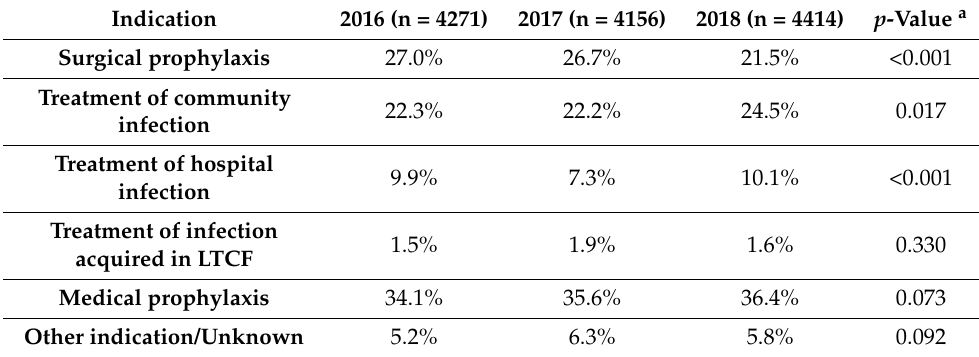
Table 3. Indication for antimicrobial use by year of the Point Prevalence